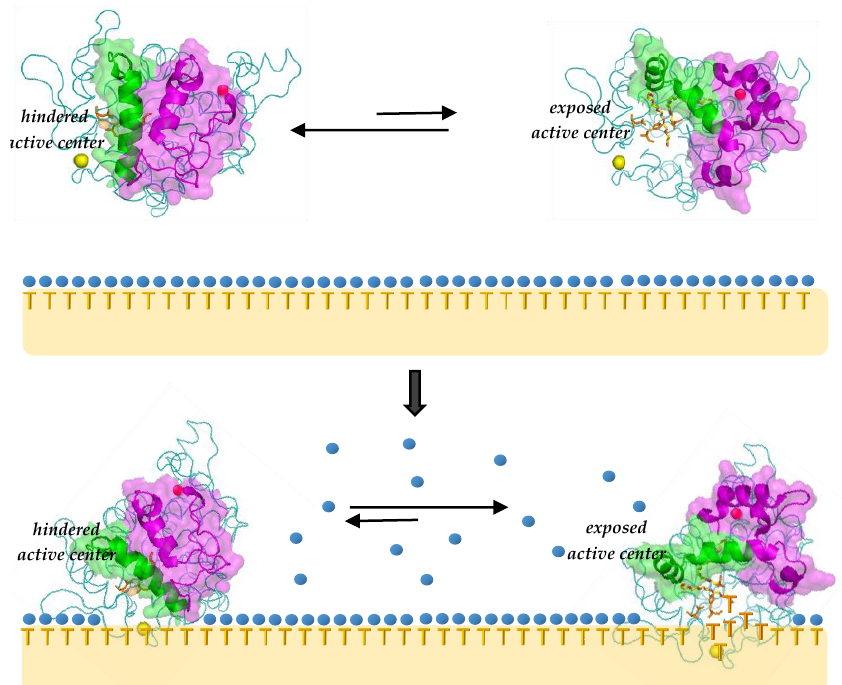
Figure 2. Scheme of open-closed conformational equilibrium of lipases (i.e. , BTL2, PDB 2w22). Upper panel (equilibrium in water): closed form ( upper left ) and the less populated open form ( upper right ). Yellow and purple spheres represents lipase structural ions. Blue spheres represent clathrate water molecules and “T” for triglycerides, both at the interphase. Lower panel: after lipase adsorption, some clathrate water molecules get desorbed and disordered as bulk water. Some individual “T” (substrate) molecules can now diffuse towards the active center of the more stable open lipase form ( lower right ), starting catalysis